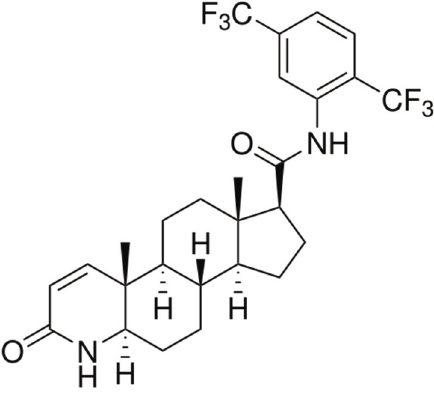
Figure 1. The chemical structure of